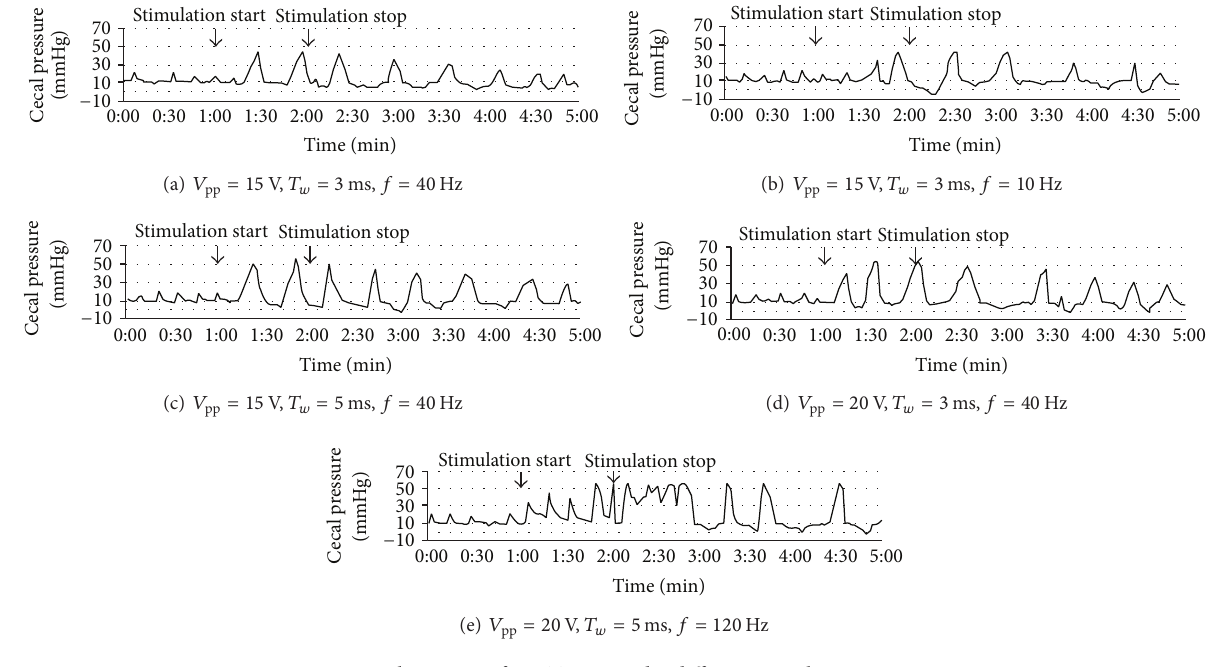
Figure 7: Cecal pressure of an STC pig under different stimulation parameters.